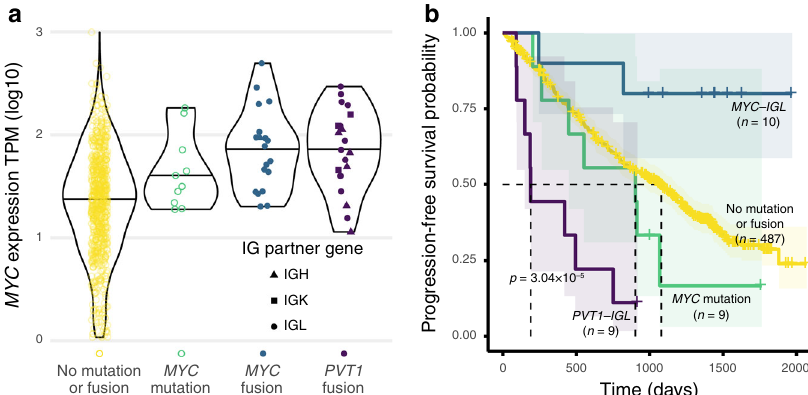
Fig. 6 MYC translocation fusion partners and survival differences. a MYC expression by MYC mutation or fusion status. Violin plots de fi ned as: No mutation or fusion (n = 696, minimum = 0.03, maximum = 3.00, median = 1.37); MYC mutation (10, 1.28, 2.26, 1.55); MYC fusion (19, 1.30, 2.69, 1.89); PVT1 fusion (21, 1.06, 2.47, 1.85). All data points from 0 to 100th percentile are shown. b Kaplan – Meier curves strati fi ed by MYC mutation or fusion status. Shaded regions indicate a 95% con fi dence interval on each survival curve. Signi fi cance p value was calculated by two-sided log-rank test and uncorrected for multiple comparisons. Source data and scripts are available at https://doi.org/10.6084/m9.